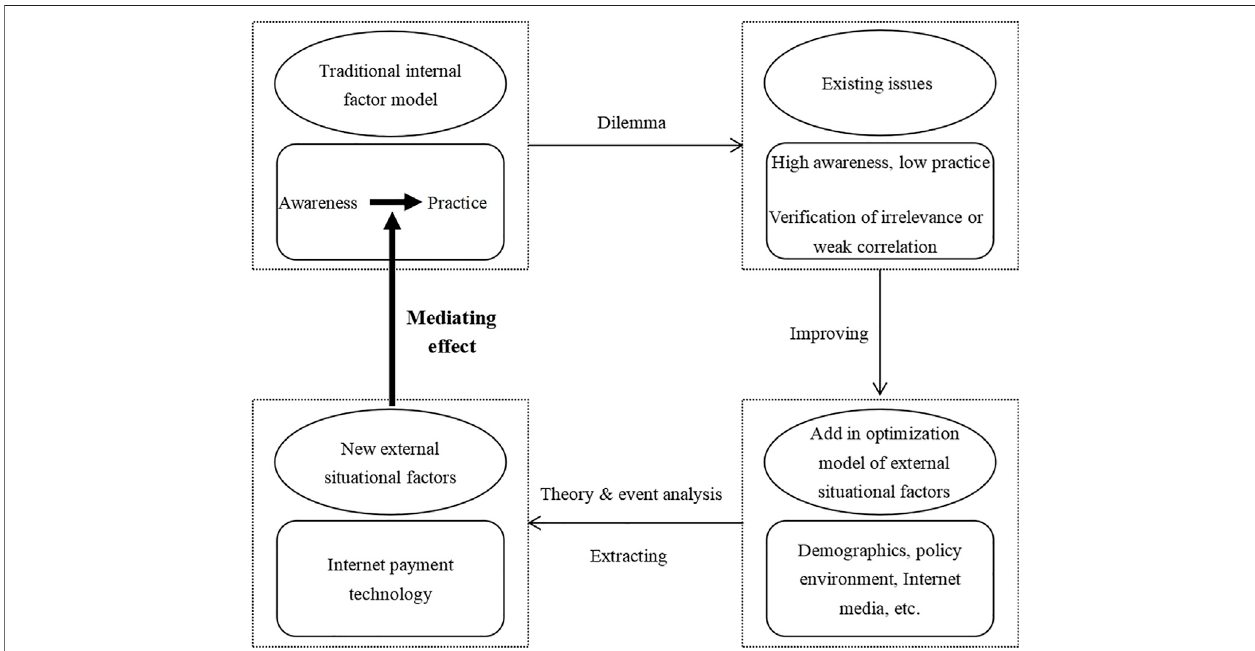
FIGURE 2 | Research logic